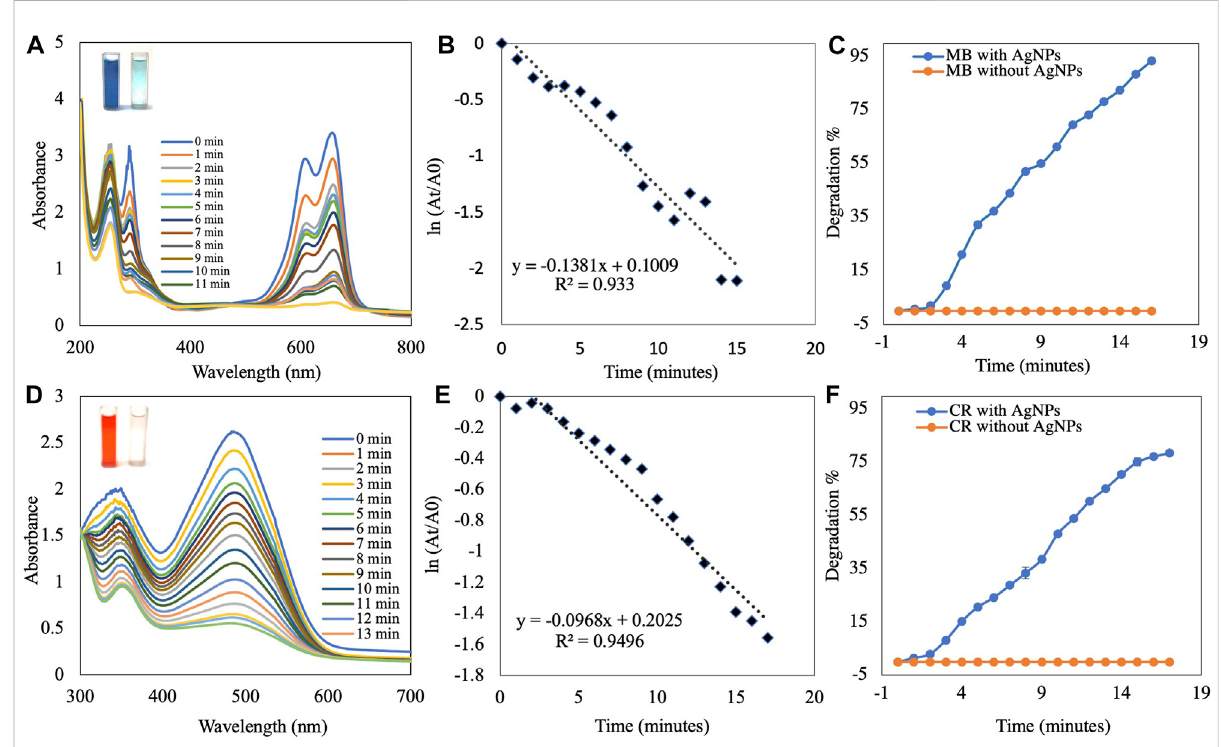
FIGURE 7 UV-visible absorption spectra analysis of (A) catalytic degradation of MB by NaBH 4 in the presence of AgNPs and (B) pseudo- fi rst-order plot of ln(A t /A 0 ) vs. time of MB. (C) Percent degradation of MB over time by AgNPs. (D) Catalytic degradation of CR by NaBH 4 in the presence of AgNPs. (E) Pseudo- fi rst order plot of ln(A t /A 0 ) vs. time of CR. (F) Percent degradation of CR over time by AgNPs.